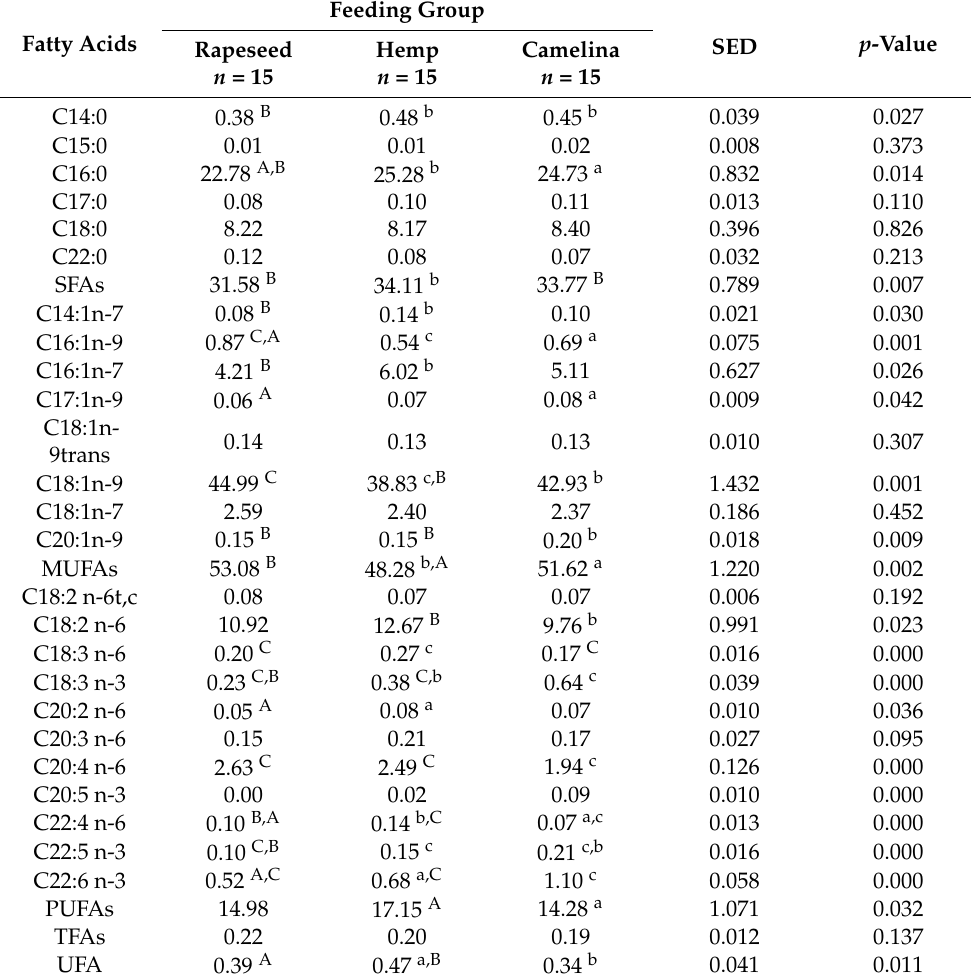
Table 6. Effects of diet on fatty acid composition (%) in yolk lipids of different quail groups. Feeding Fatty Acids